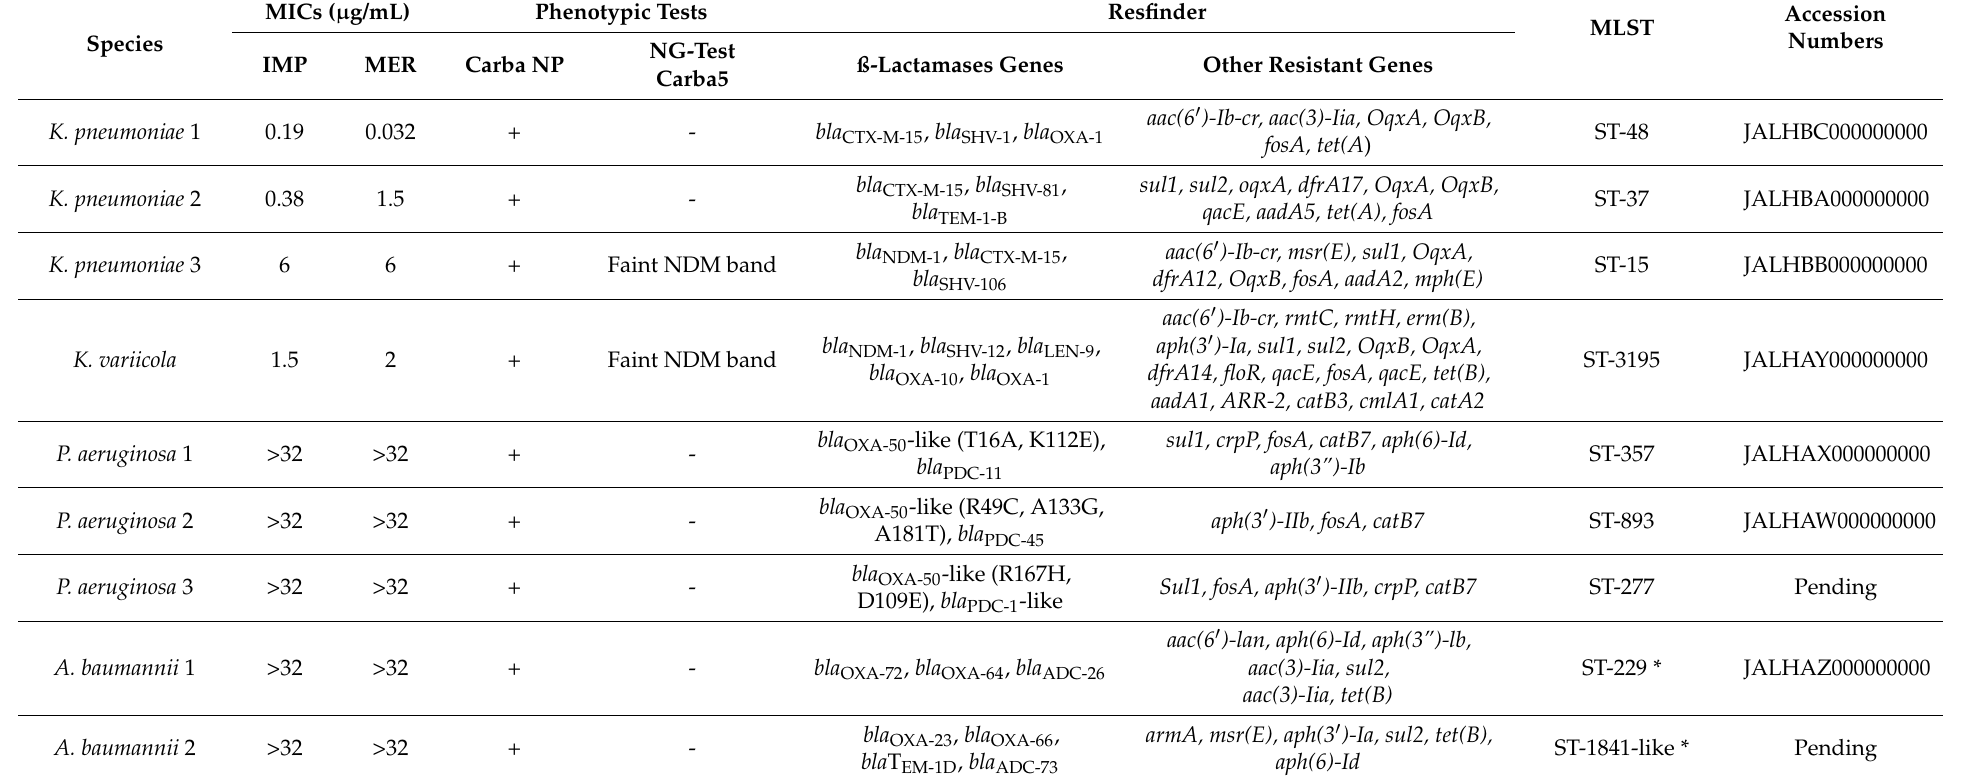
Table 3. WGS analysis of selected isolates using Resfinder and